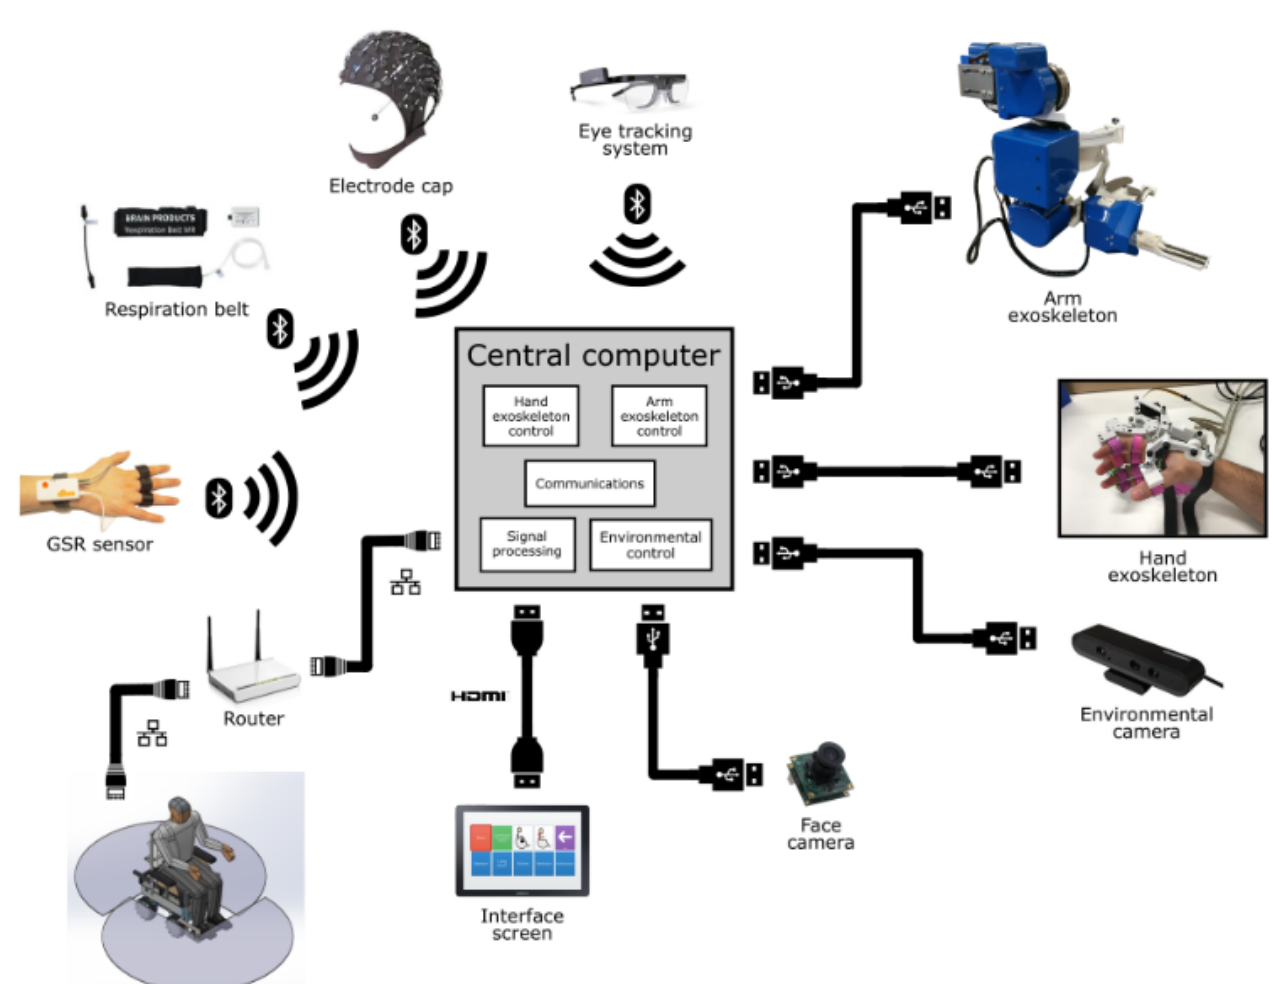
Figure 4. Diagram with the connections between all the components of the